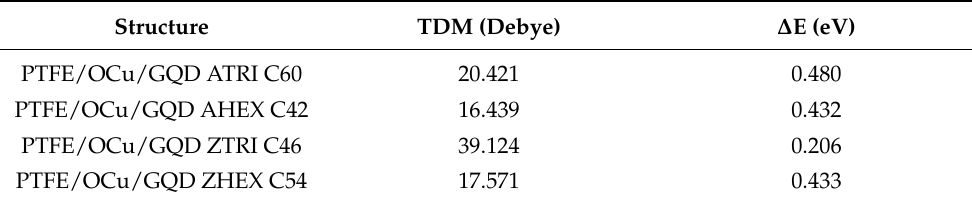
Table 2. TDM (Debye) and ∆ E (eV) of GQDs interaction with PTFE/OCu using B3LYP/LANL2DZ. Structure TDM (Debye) ∆ E